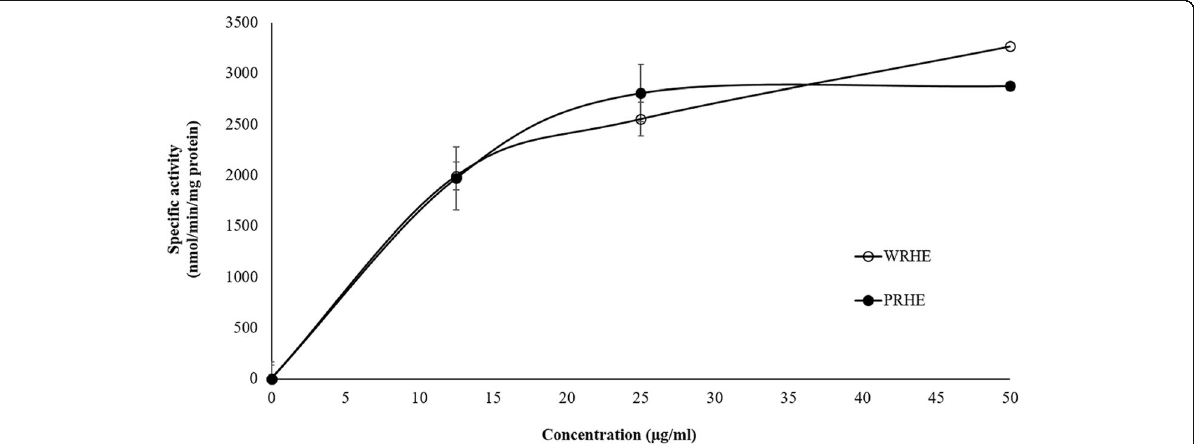
Fig. 3 Effect of rice husk extracts on NAD(P)H quinone oxidoreductase inducing activity in the Hepa1c1c7 hepatoma cell line. Values expressed as mean ± SD. WRHE: white rice husk extract; PRHE: purple rice husk extract